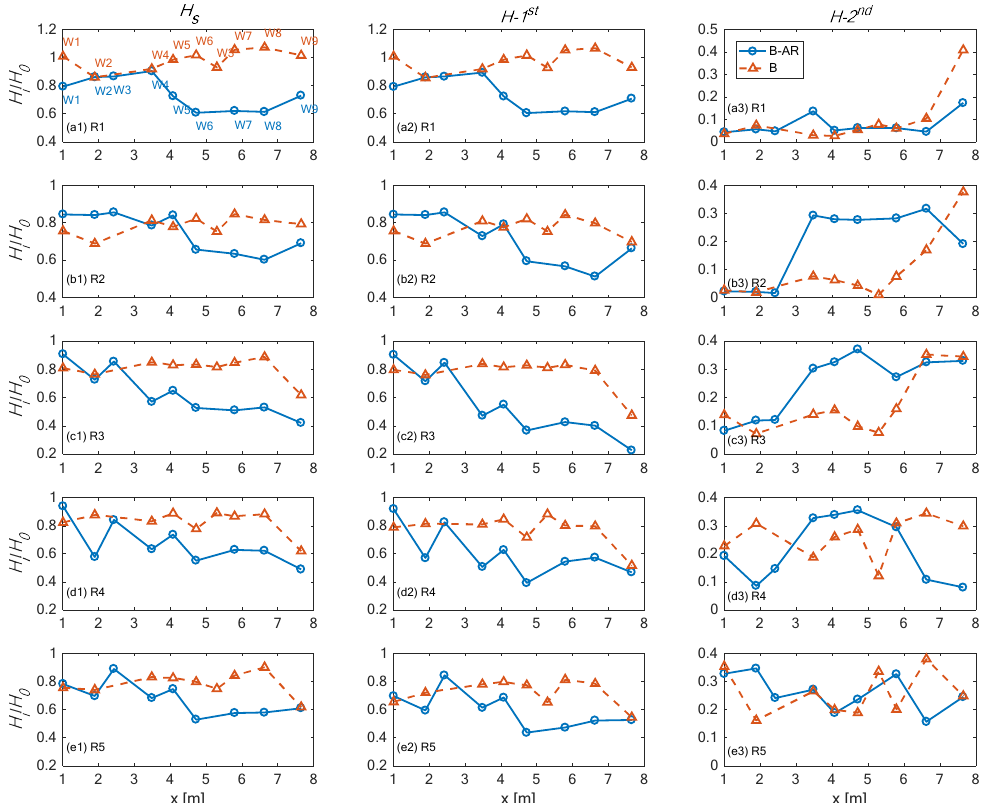
Figure 5. The cross-shore distribution of characteristic wave height ( H i ) relative to the incident wave height ( H 0 ) in regular wave tests (panels sorted by ( a – e ) indicate the wave conditions from R1 to R5; for a specific wave condition, three panels from left to right, numbered 1, 2, 3, show the transformation of significant wave height, the 1st- and the 2nd-components, respectively; H 0 is the model wave height in Table 1; W1–W9 are the wave gauges in Figure 2).